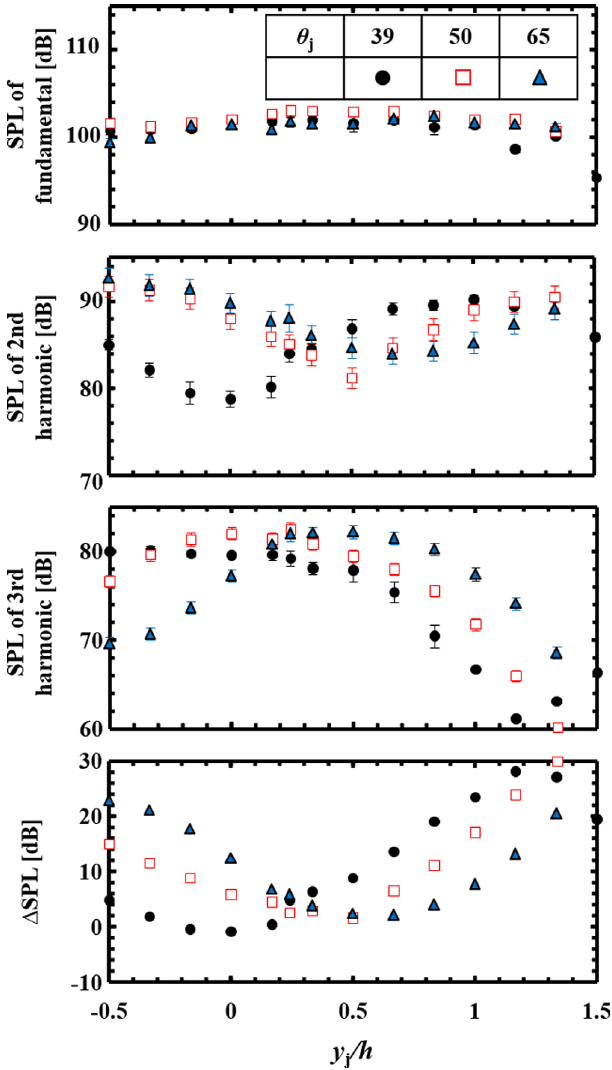
Figure 13. Variations of harmonic structure with jet offset, where lip-to-edge distance and fl owrate were fi xed to the actual blowing conditions shown in Table 1 ( l / h = 5.6, Q = 16